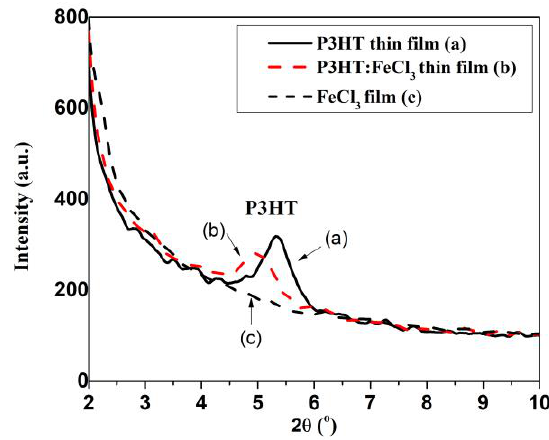
Figure 2. XRD patterns of sensitizing agent and polymer thin films.